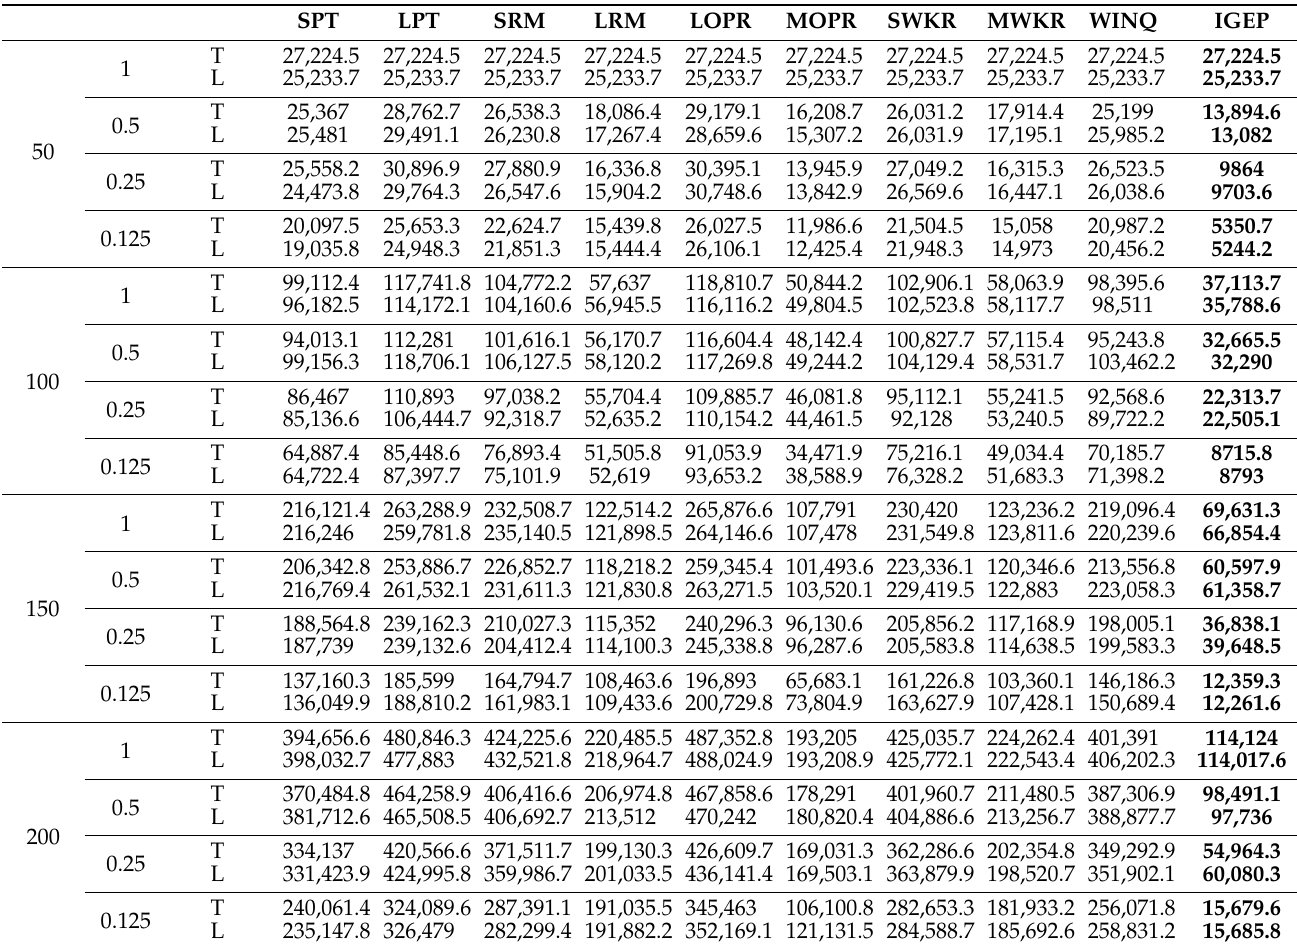
Figure 8. RPD for MOPR and IGEP under different scenario. Table 5. Comparison of discovered/combination rules with minimum total flow